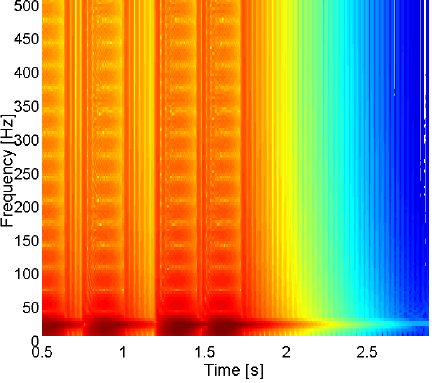
Fig. 23. 2D spectrogram of acceleration signal: Linear case. Fig. 24. 2D spectrogram of acceleration signal: Nonlinear case.